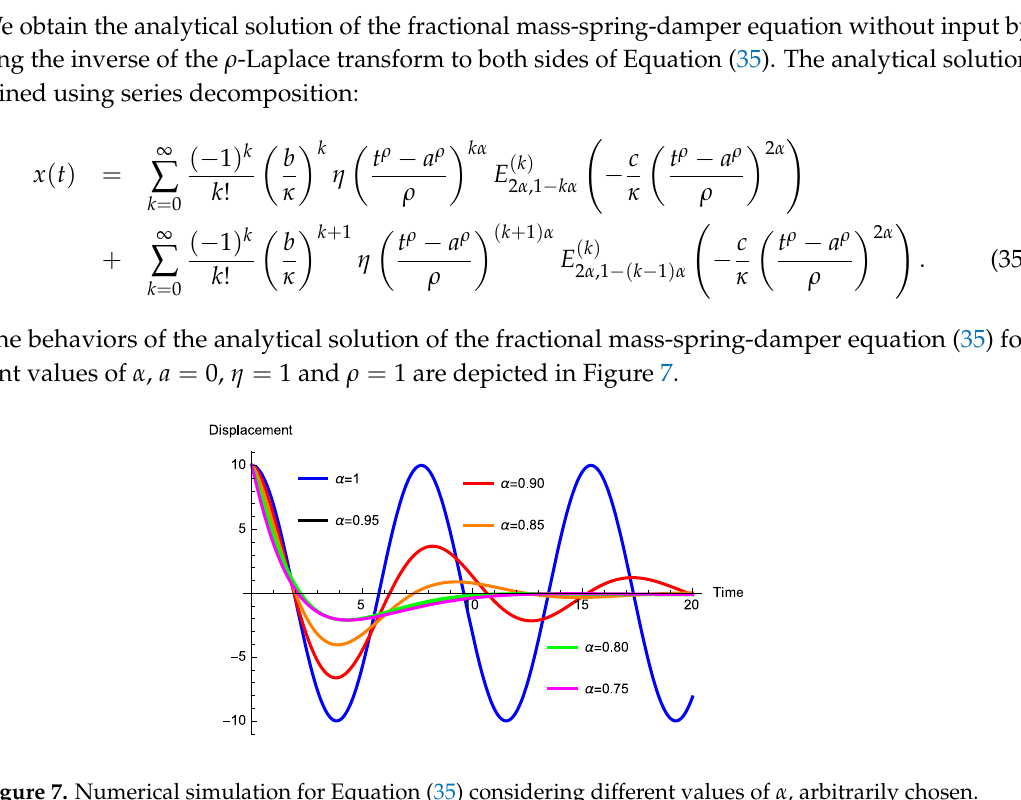
Figure 7. Numerical simulation for Equation (35) considering different values of α , arbitrarily